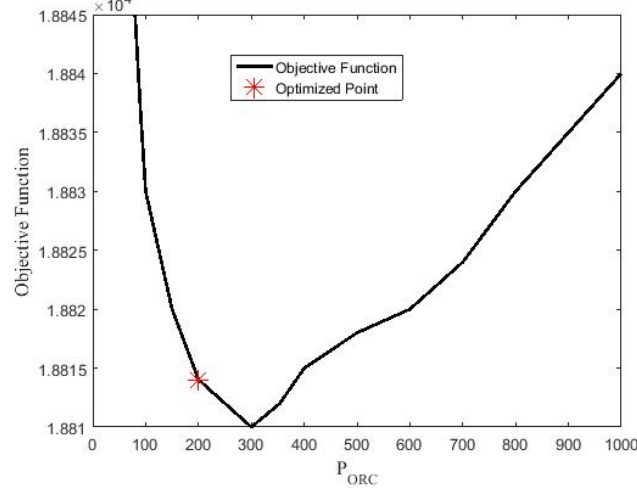
Figure 9. Variations in the objective function with the input pressure of the ORC turbine.